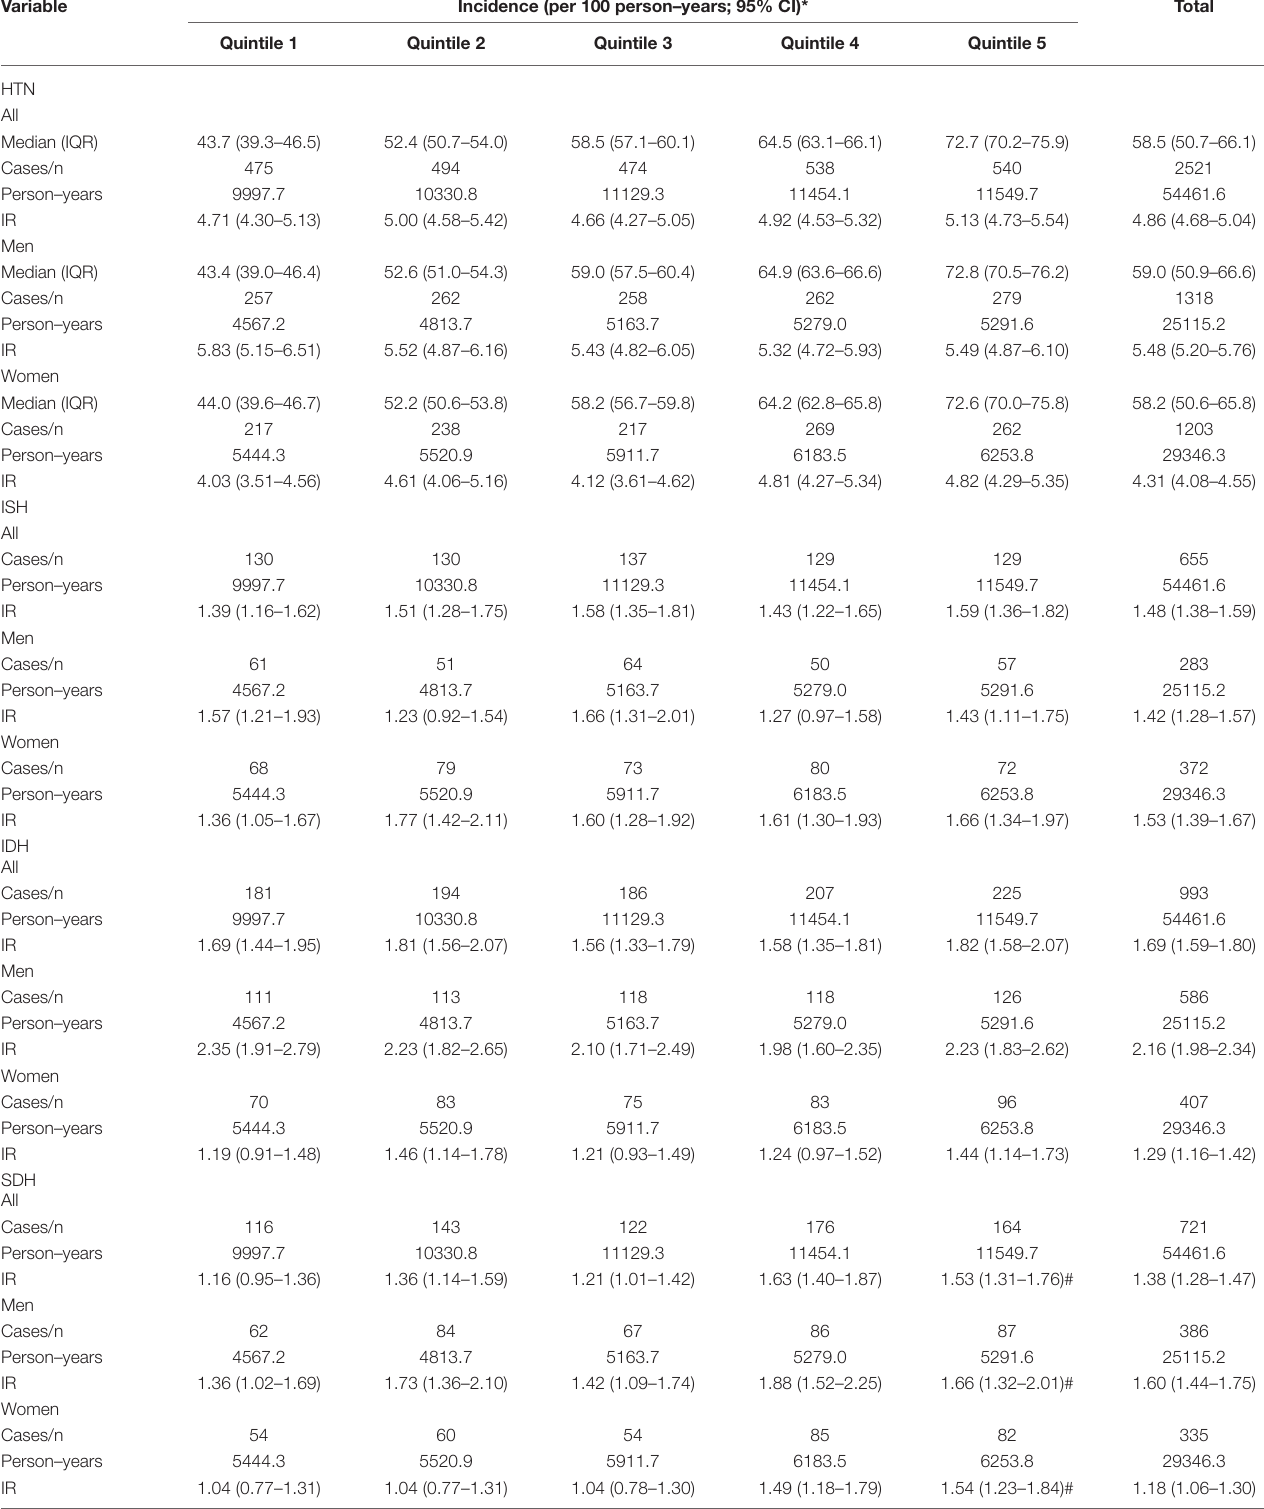
TABLE 3 | Incident rates of hypertension and subtypes in participants by quantiles of percentage energy from carbohydrate.